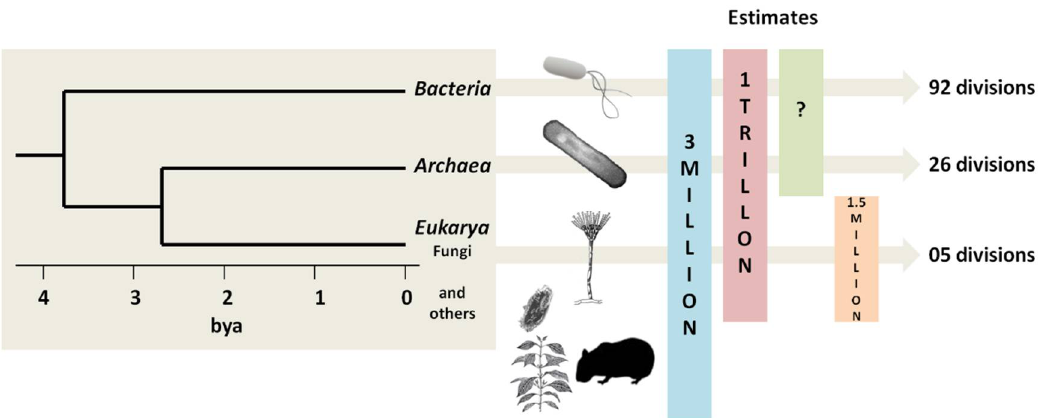
Figure 1. Estimates of the number of microbial species present in the three domains of life. Bacteria are the oldest and most biodiverse group, followed by Archaea and Fungi (the most recent groups). It is estimated that on the planet there are 3 million species of living organisms [11], but strangely, the number of microorganisms has been estimated at 1 trillion [30].